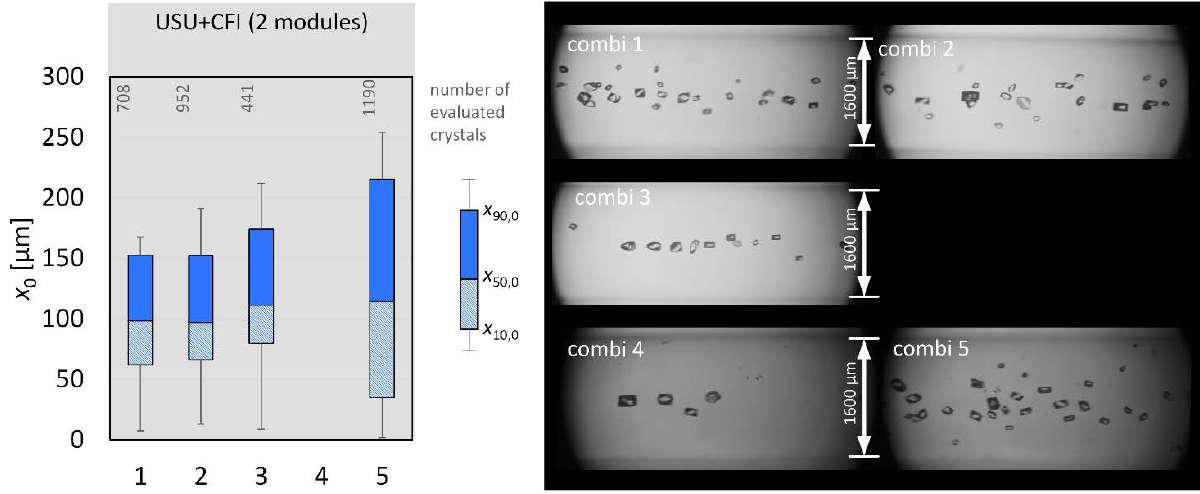
Figure 11. Combined nucleation and crystal growth experiments: left, crystal size distribution (via image analysis) shown as boxplots; right, microscopic pictures in the non-invasive measurement flow-cell.